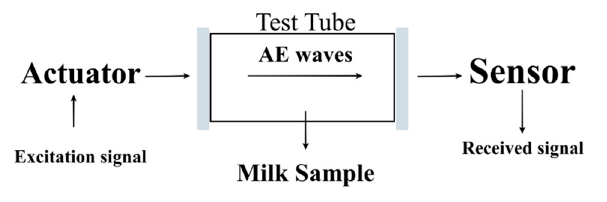
Figure 1. Acoustic liquid characterization to assess adulteration in bovine milk.